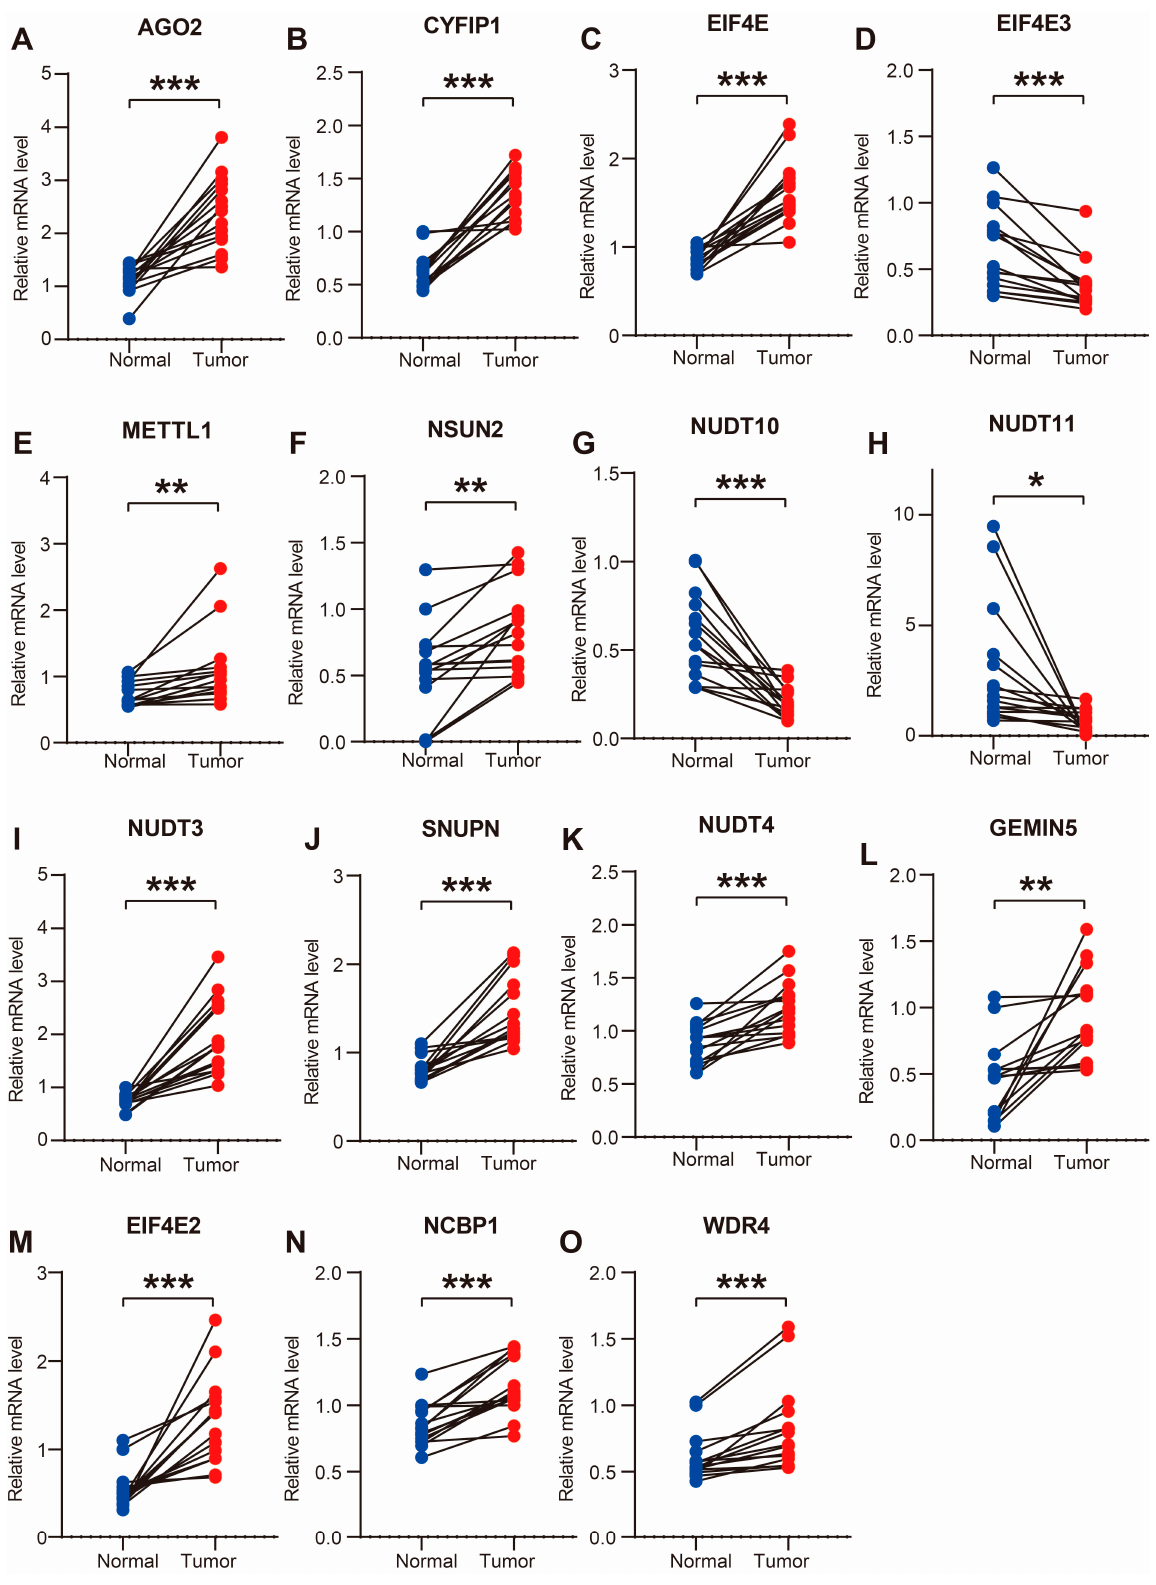
Figure 7. Validation of the expression level 15 prognostic m7G-related genes in human CC tissues. ( A – O ) Expression level of prognostic m7G-related genes in 15 paired human CC and adjacent